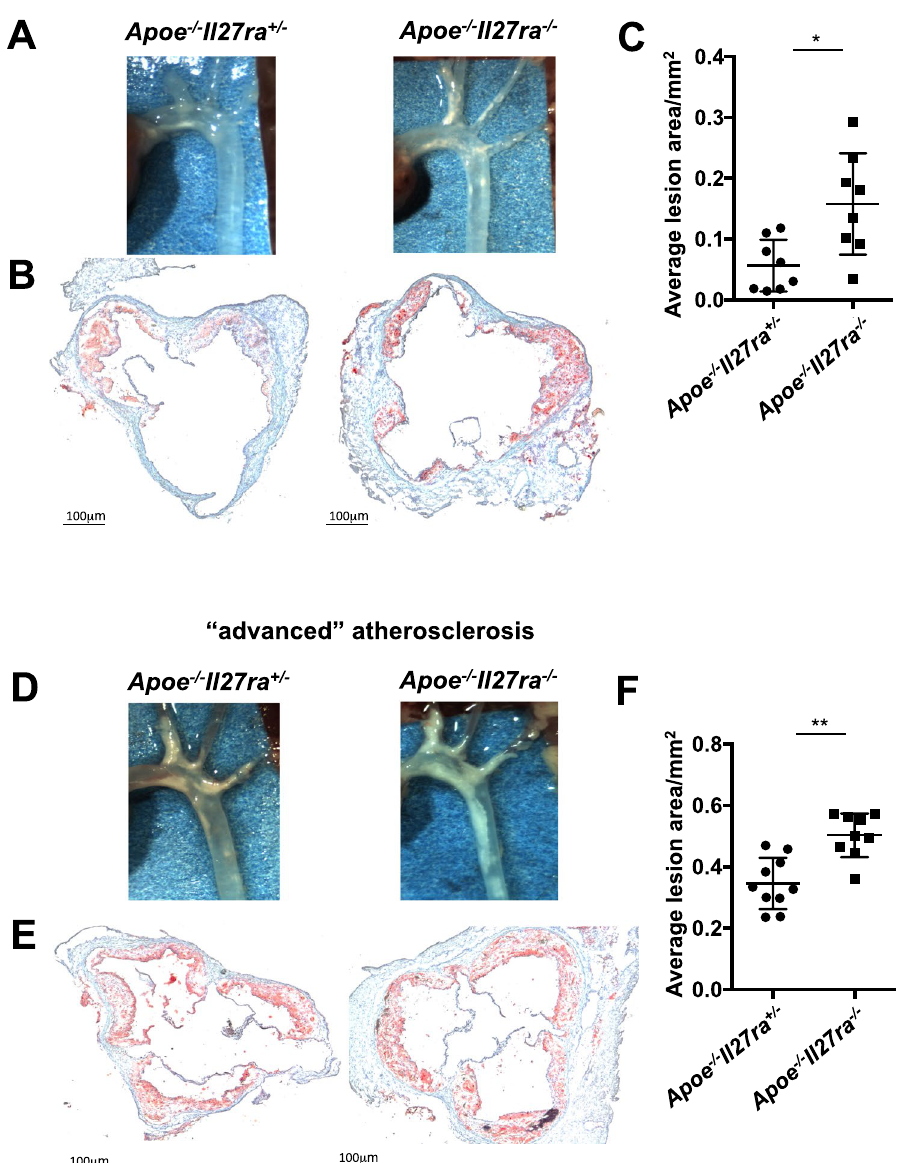
Figure 1. Accelerated atherosclerotic lesions development in Apoe − / − Il27ra − / − mice. Apoe − / − Il27ra + / − or Apoe − / − Il27ra − / − mice were fed with Western diet (WD) for 7 ( A–C ) or 18 weeks ( D–F ). Atherosclerotic lesions in aortic arch ( A ) and aortic root sections ( B ) of Apoe − / − Il27ra + / − and Apoe − / − Il27ra − / − mice fed with WD for 7 weeks. ( C ) Quantitative comparison of aortic lesion size in Apoe − / − Il27ra + / − (n = 8) and Apoe − / − Il27ra − / − (n = 8) mice feeding with WD for 7 weeks. Atherosclerotic lesions in aortic arch ( D ) and aortic root sections of ( E ) Apoe − / − Il27ra + / − and Apoe − / − Il27ra − / − mice fed with WD for 18 weeks. ( F ) Quantitative comparison of aortic lesion size in Apoe − / − Il27ra + / − (n = 10) and Apoe − / − Il27ra − / − (n = 9) mice feeding with WD for 18 weeks. Data are mean ± SEM from 4 independent